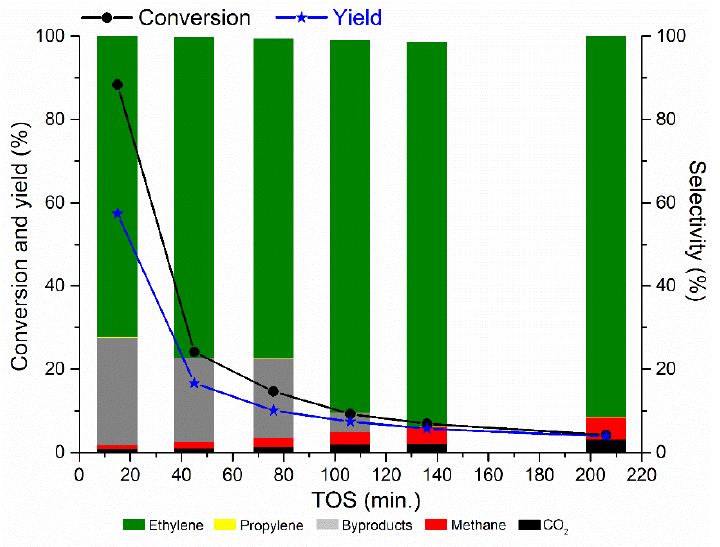
Figure 1. Conversion, yield, and selectivity dependence of ethane ODH as a function of time on stream for S-ACl.